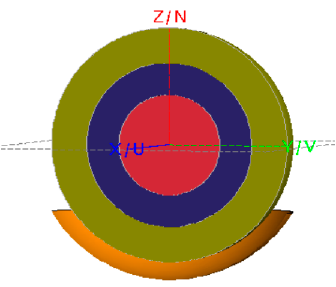
Figure 5. Simulation structure of a Luneburg ball reflector. The Luneburg ball simulation structure consists of three dielectric layers and an outermost air layer. Equation (4) can be used to calculate the relative permittivity of the dielectric layer. Table 1 shows the specific design parameters. Table 1. Design of the dielectric constant of each layer of a Luneburg ball. Layers